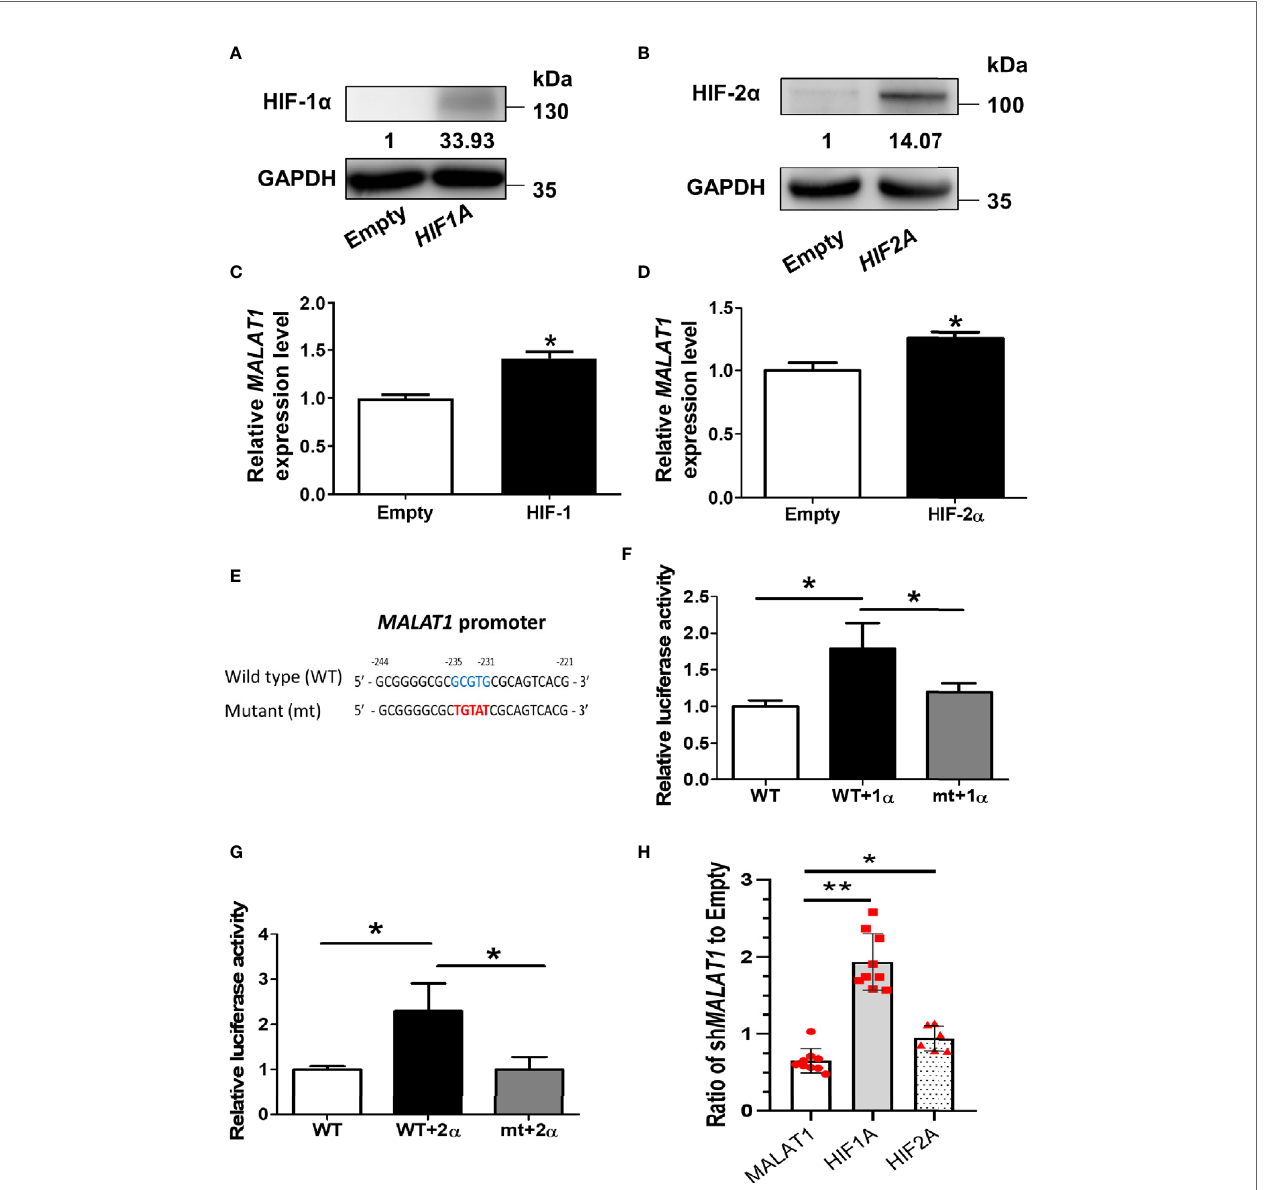
FIGURE 2 | HIF-1 a and HIF-2 a up-regulate the transcriptional levels of MALAT1 . (A) Western blot analysis of HIF-1 a in MCF-7 cells over-expressing HIF-1 a - P402A/P564A under normoxia. (B) Western blot analysis of HIF-2 a in MCF-7 cells over-expressing HIF-2 a -P405A/P531A under normoxia. (C, D) Relative expression levels of MALAT1 in MCF-7 cells overexpressing HIF-1 a -P402A/P564A (C) or HIF-2 a -P405A/P531A (D) . The expression levels were measured by qPCR. (E) Schematic diagram of the putative HRE ([A/G]CGTG; -235 ~ -231 bp) in the promoter region (-2,000 ~ -1 bp) of MALAT1 . (F, G) Luciferase reporter assays of wild-type (WT) and mutant (mt) MALAT1 promoters in HEK-293T cells overexpressing HIF-1 a -P402A/P564A (F) or HIF-2 a -P405A/P531A (G) . HEK-293T cells were transfected with HIF-1 a or HIF-2 a expressing plasmids, fi re fl y luciferase plasmids, and Renilla luciferase vectors. The relative fi re fl y luciferase activity was measured and normalized to Renilla luciferase activity. All data shown are the means ± SDs (n = 3). * P < 0.05. (H) Relative expression levels of MALAT1 , HIF1A , and HIF2A in MCF-7 cells transduced with sh MALAT1 .The expression levels were measured by qPCR. Loading control: 18S rRNA. ** P < 0.01. * P <